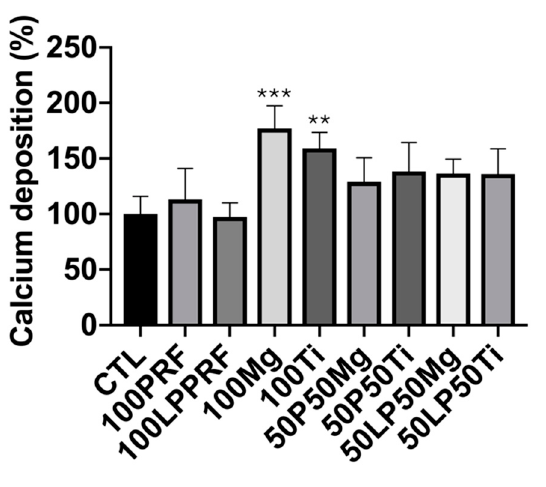
Figure 9. Scanning electron microscopy images of MC3T3-E1 preosteoblasts cultured on ( a , b ) large-pore platelet-rich fibrin and ( c , d ) platelet-rich fibrin captured with different magnification.